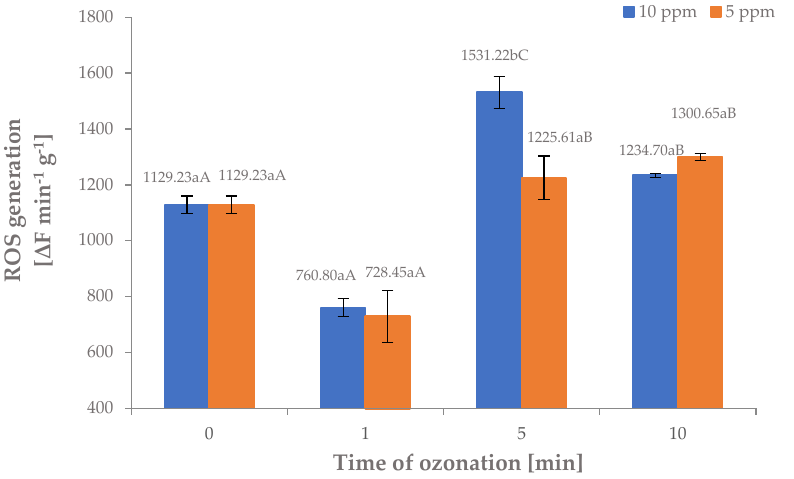
Figure 4. ROS generation in Kalanchoe daigremontiana leaves depending on the duration of ozone treatment (n = 20): differences between the results for duration of ozone treatment on specific days are marked with small letters, and differences between dose of ozone (ppm) measurements are marked with capital letters; significance level is defined as p < 0.05.